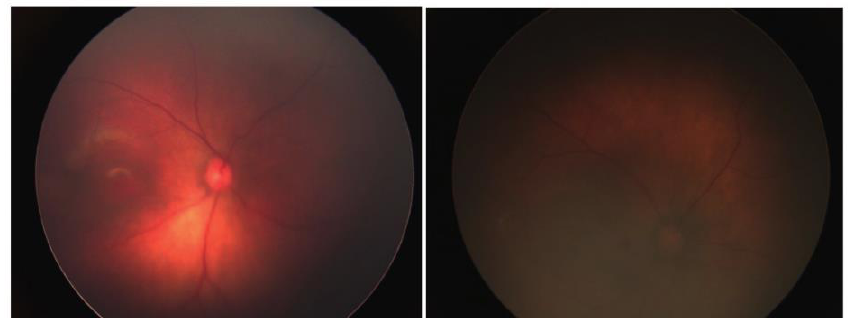
Figure 5. Examples of some of the misclassified retinal fundus images. NOROP test cases were predicted to be ROP test cases.